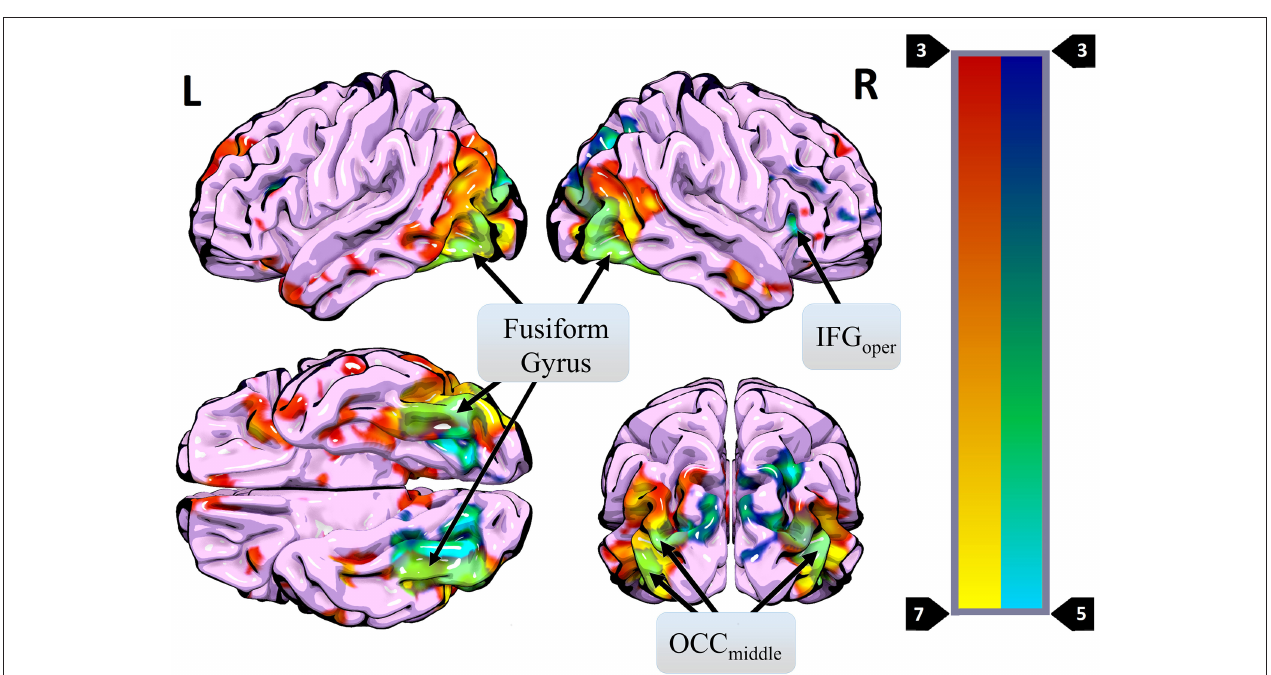
FIGURE 4 | Regions where more activity was observed during presentation of different HWL images (vs. the same image two times in a row) (blue) overlaid on regions where more activity was observed for real images than phase-scrambled images (red). Areas of overlap are shown in light green. Regions active in both contrasts included the right IFG oper , bilateral OCC middle , and bilateral fusiform